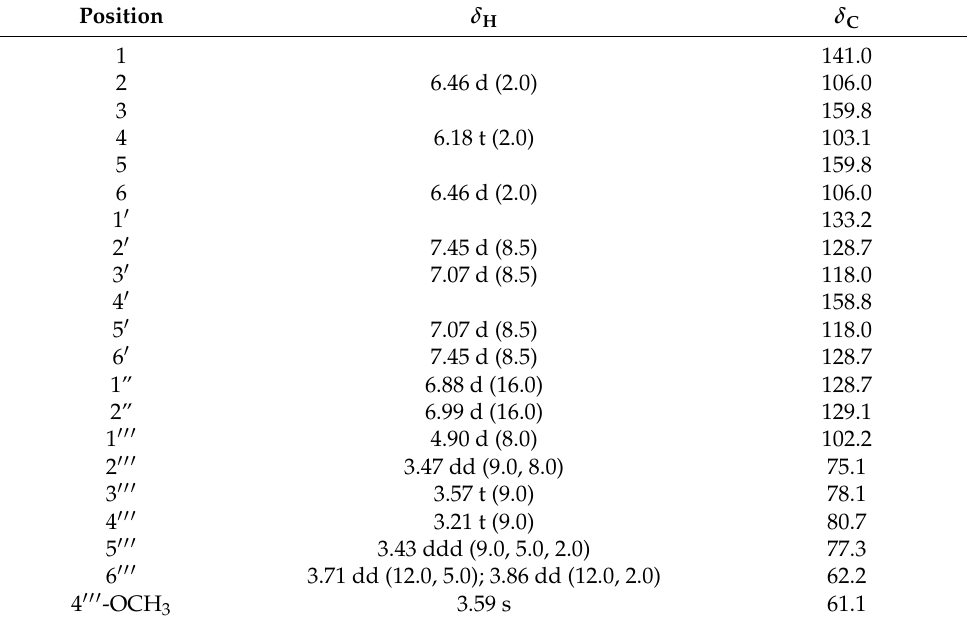
Table 1. 1 H (700 MHz) and 13 C NMR (175 MHz) Data of Resvebassianol A ( 1 ) in CD 3 OD a